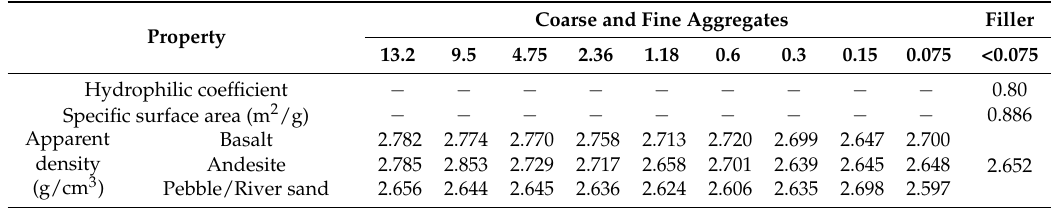
Table 2. Physical properties of aggregates and